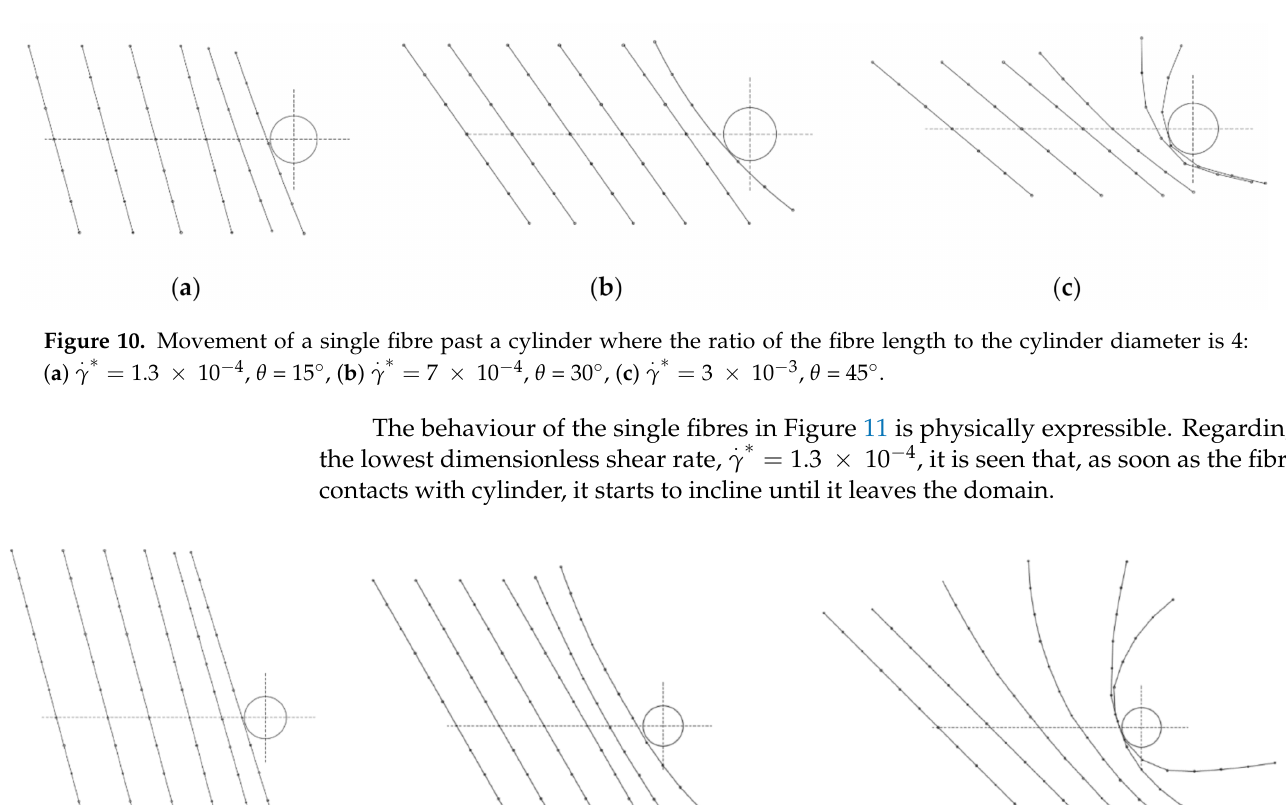
. ∗ = γ 7 × 10 − 4 , θ = 30 ◦ , ( c )